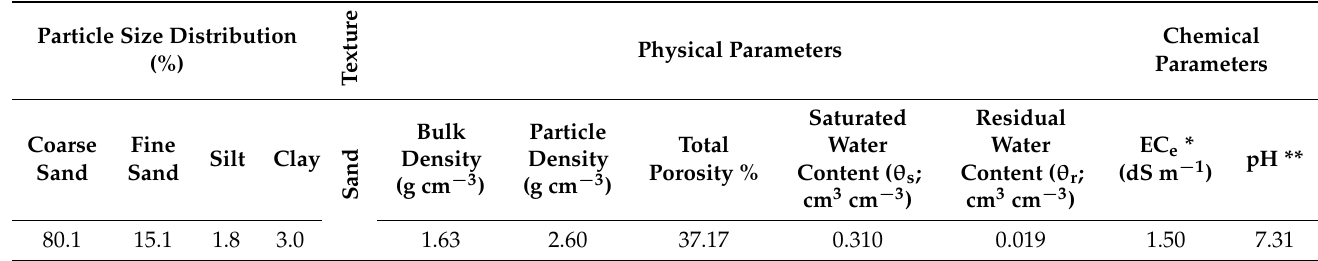
Table 1. Physical and chemical properties of the experimental soil.